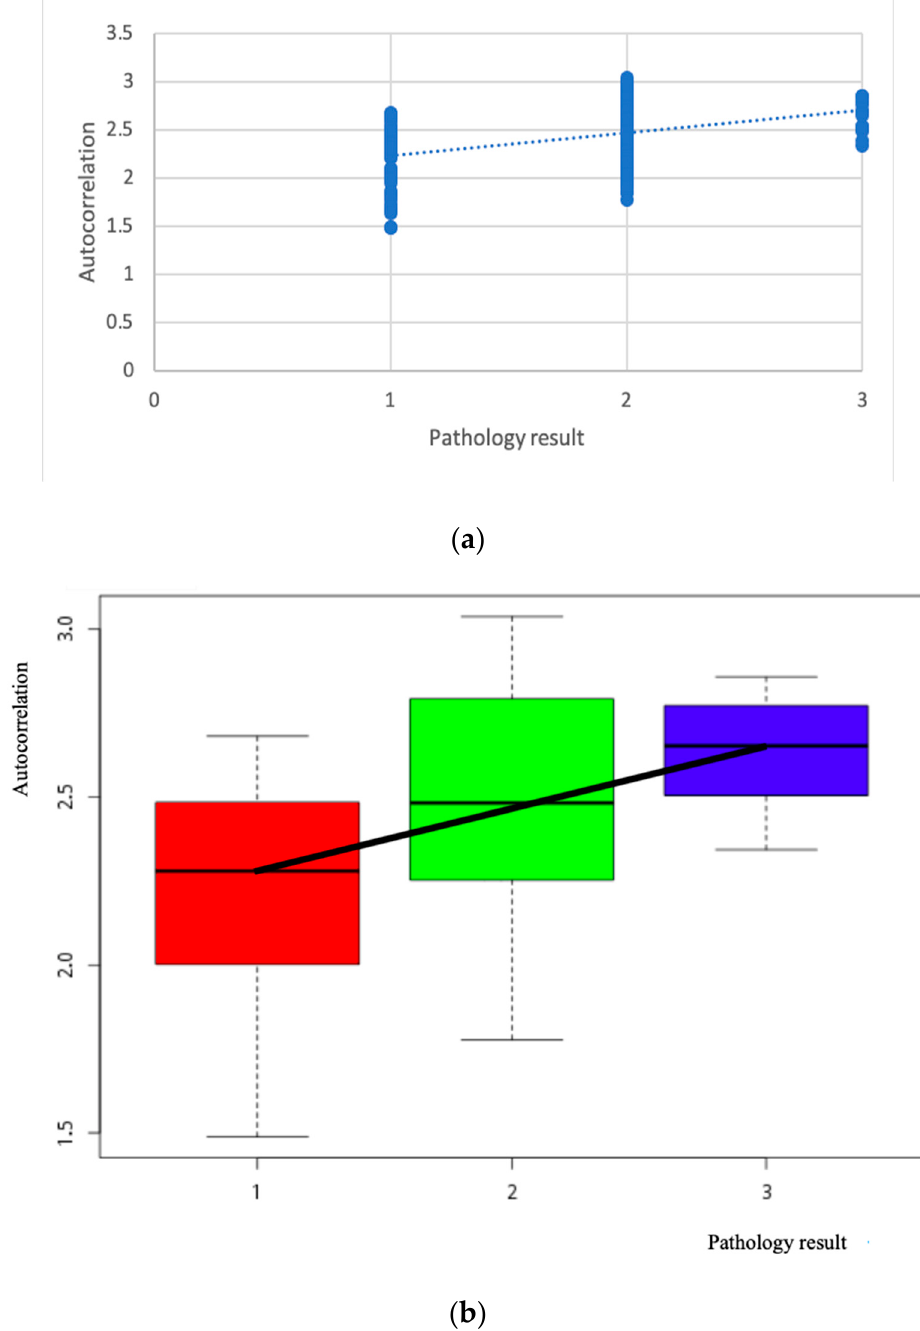
Figure 4. The correlations between autocorrelation and pathological results ( a ) scatter plot and ( b ) box-and-whisker plot. Pathology result 1 is hyperplastic polyps. Pathology result 2 is adenoma. Pathology result 3 is colon adenocarcinoma.